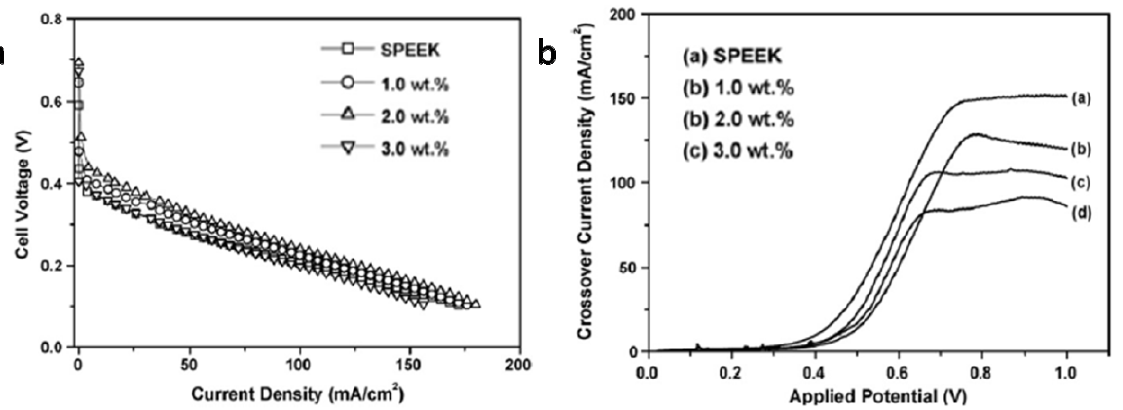
Figure 8. ( a ) Comparison of the polarization curves of the plain SPEEK and SPEEK/BBImIP blend membranes in direct methanol fuel cells (DMFCs); and ( b ) comparison of the variations of the methanol crossover current density for the